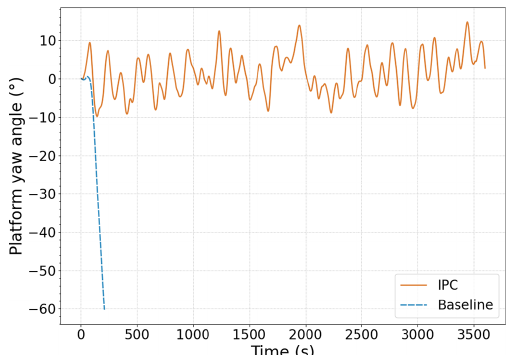
Figure 13. Platform yaw angle with (solid orange) and without yaw-by-IPC loop (dashed blue) and turbulent mean wind speed of 20ms − 1 .